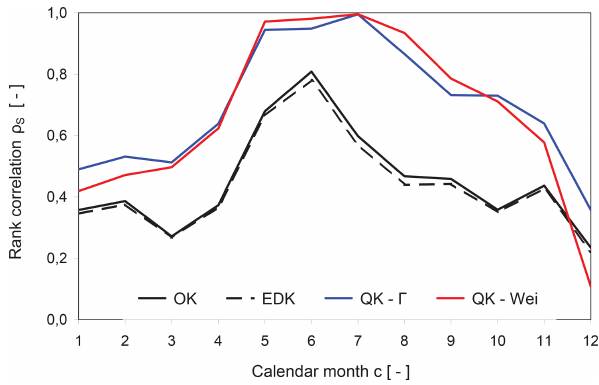
Figure 8. Evolution of the Spearman rank correlation coefficient ρ S between the estimator Z ∗ and the standard deviation σ K